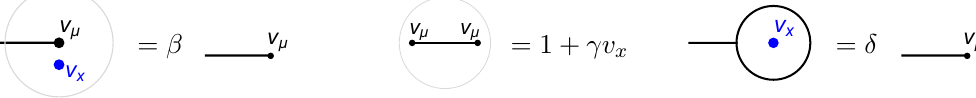
Figure 40 . Some OPEs in the IR TQFT.